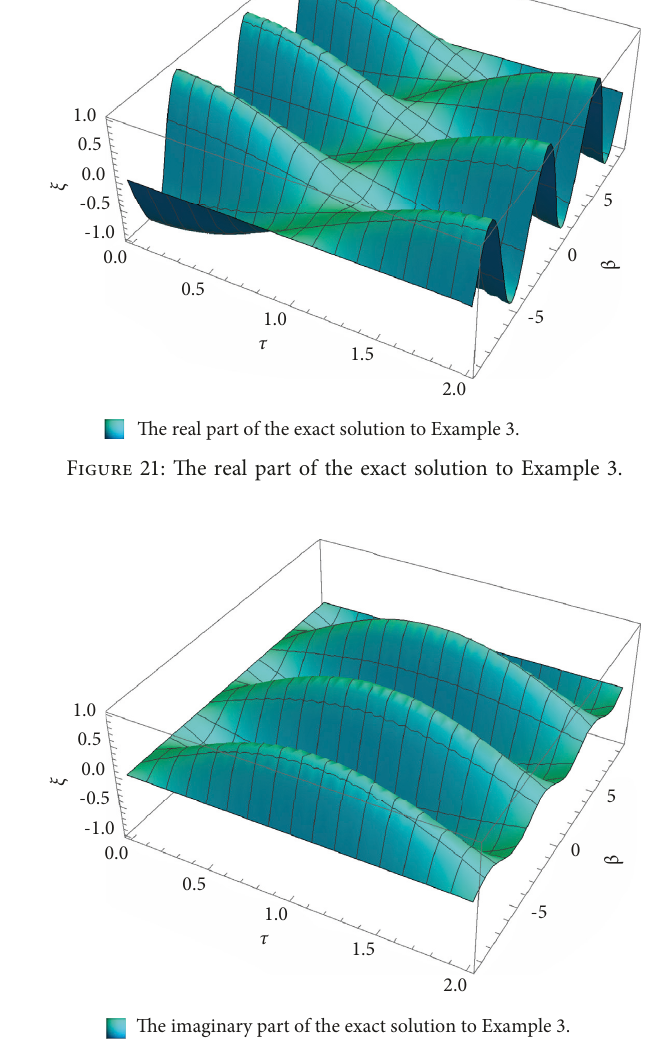
Figure 22: The imaginary part of the exact solution to Example